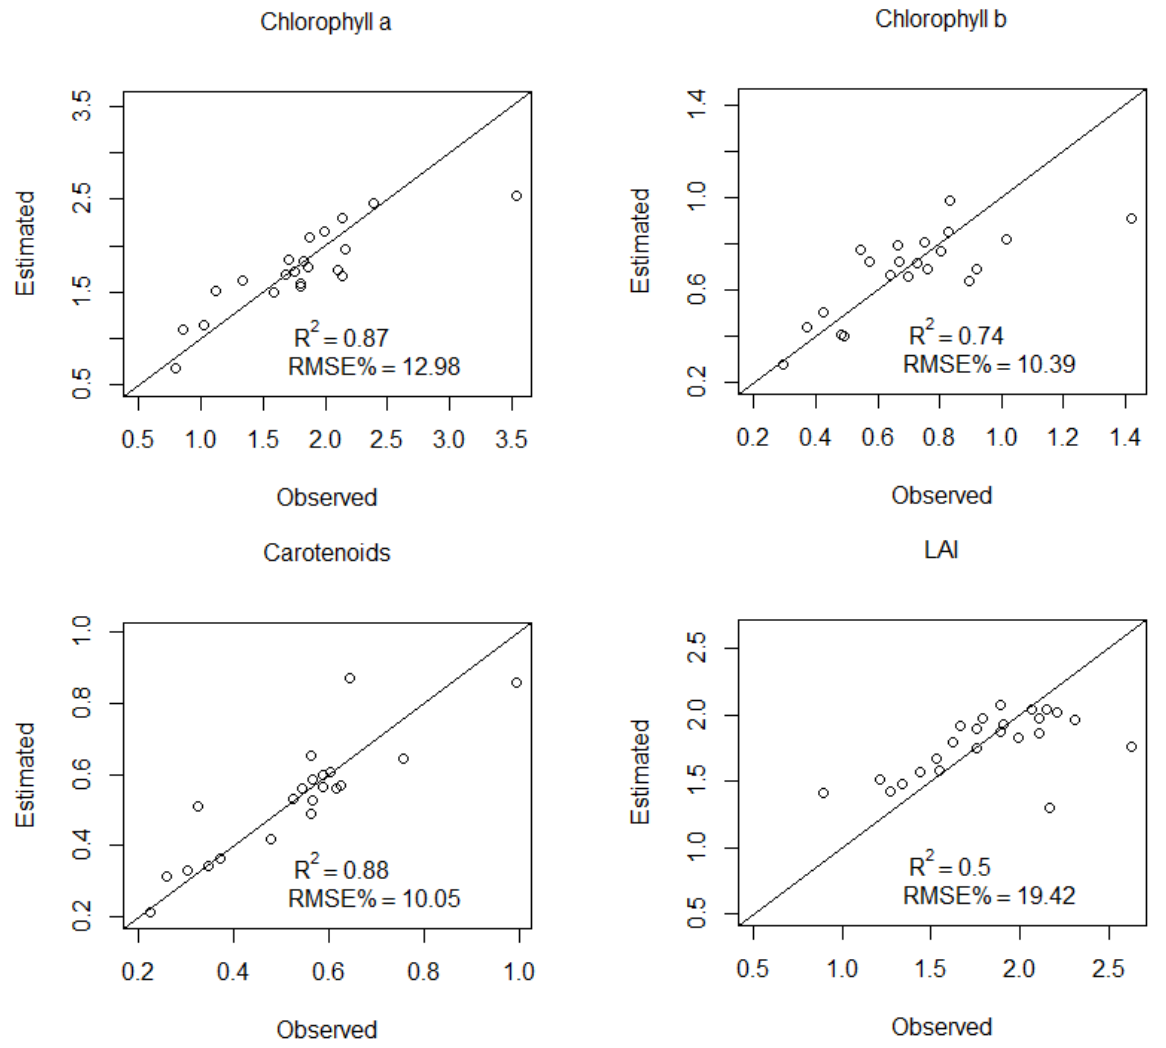
Figure 4. Bivariate relationships between imputed and observed chlorophyll content ( Chla and Chlb ), carotenoids ( Car ), and LAI estimated by the k -NN imputation using Random Forest distance for regression modeling in Pinus sylvestris plantations at Sierra de los Filabres (Almería, Spain). In all figures, the linear 1:1 line has been fitted. For these equations, the R 2 and RMSE values are included.